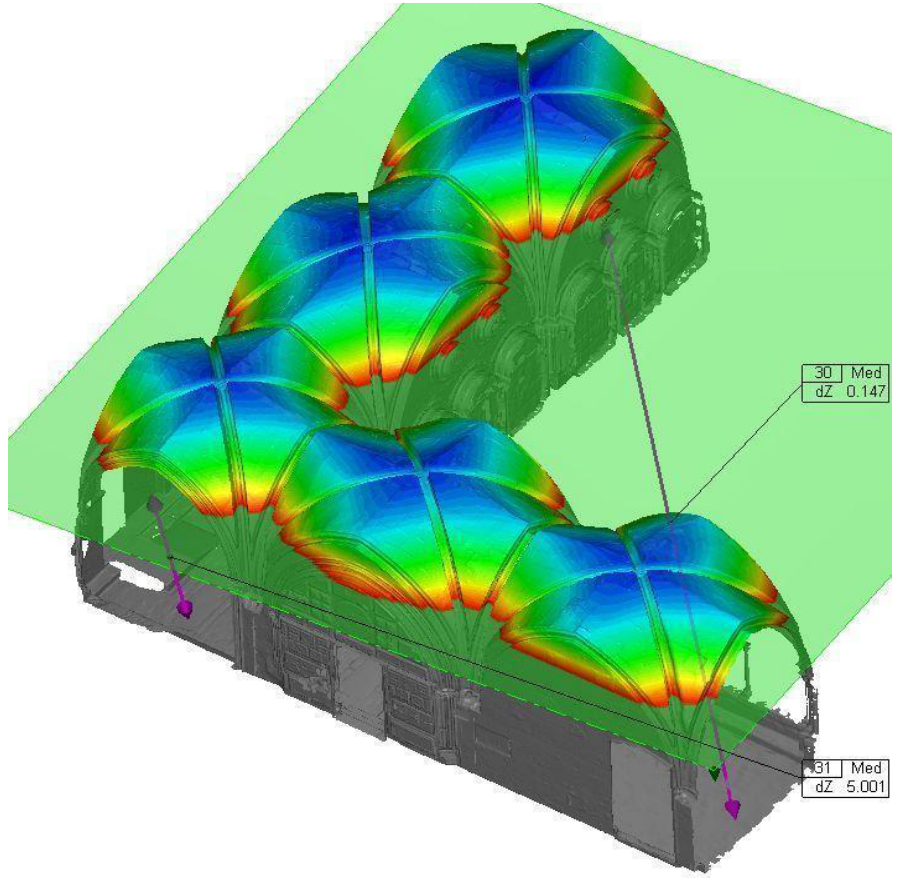
Figure 5. Horizontal reference planes (units in meters).